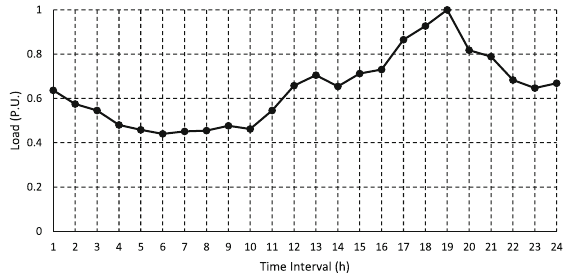
Fig. 4 Single line diagram of the test network